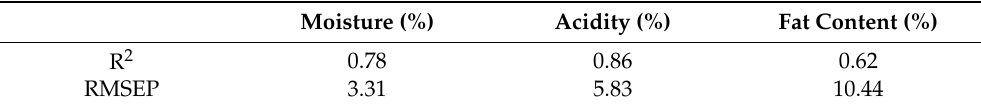
Table 3. R 2 and RMSEP between reference values of olive fruit moisture, acidity, and fat content and those estimated values based on ANN approaches.